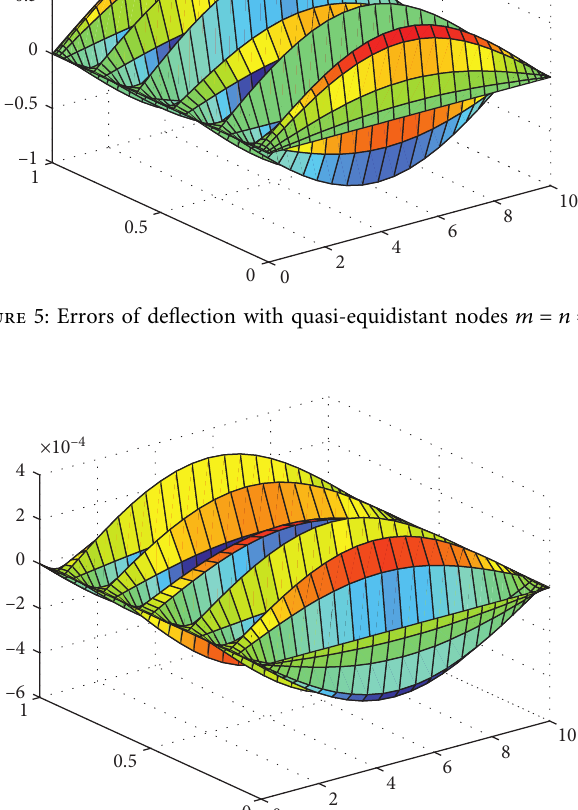
� d � 25. 1 2 ( d � 7 ) . 1 2